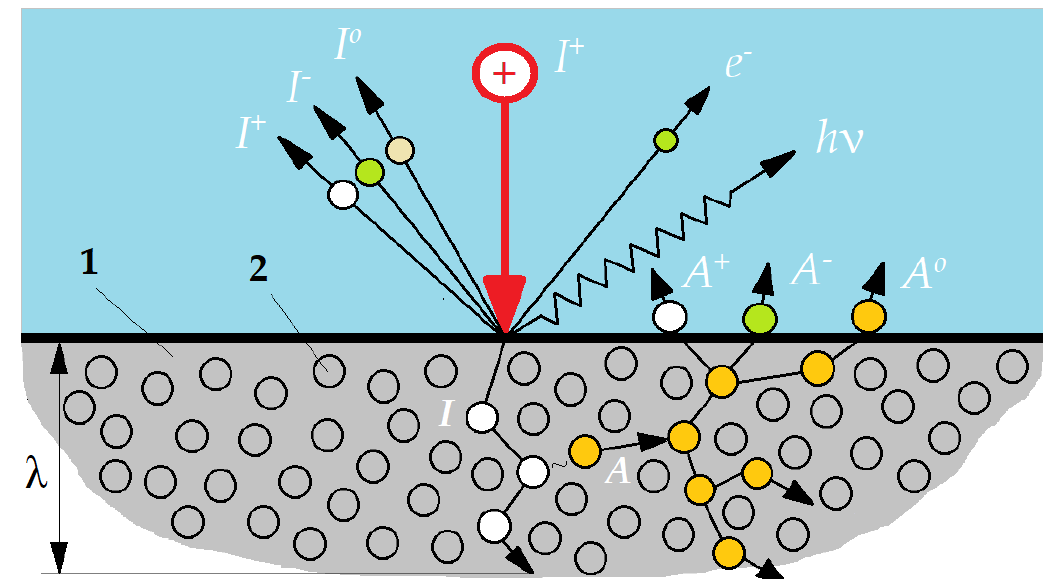
Figure 9. Scheme of a cascade of elastic collisions of atoms in a material under ion bombardment, where I + , I − , and I o are the bombarding and backscattered ions in different charge states; ( 1 ) is the surface to be machined; ( 2 ) is an unexcited atom of the material; A + , A − , and A o are the sputtered atoms in different charge states; e − is secondary electrons; h ν is photons, λ is an ion free path that is less than the defect zone.